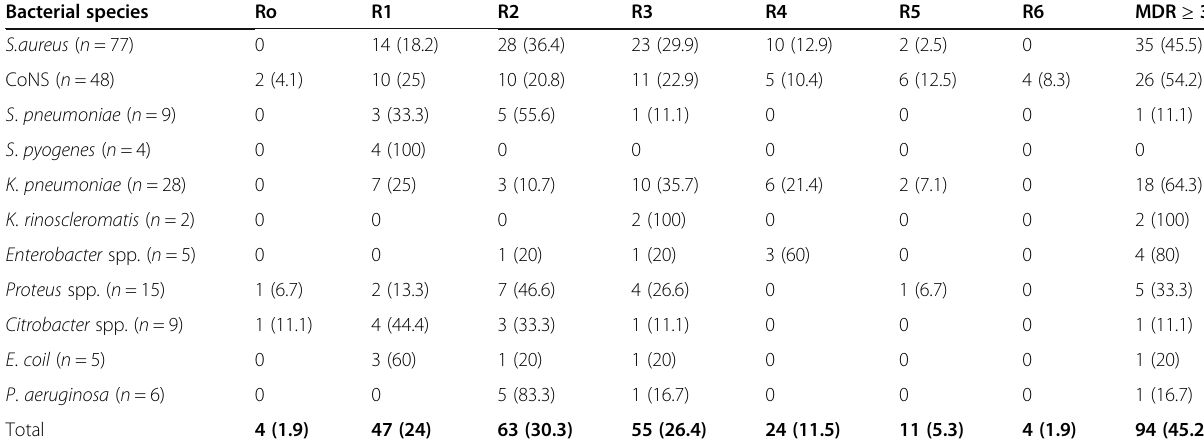
Table 6 Antibiogram of bacterial isolates from external ocular infections at Felege Hiwot Referral Hospital, 2019 Bacterial species Ro